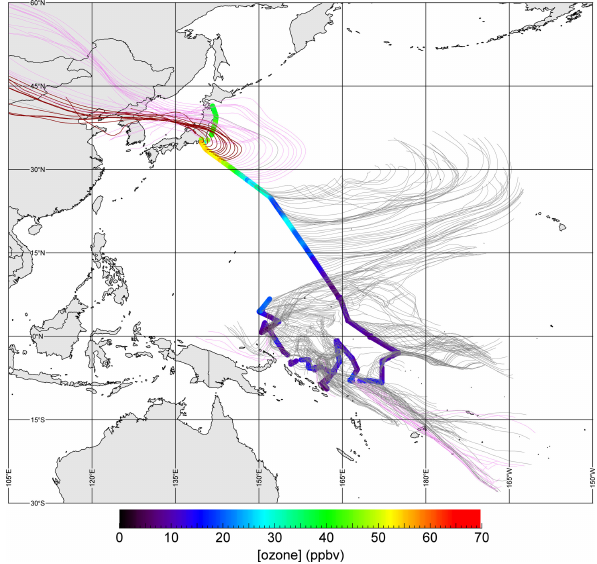
Figure 3. Observed O 3 mixing ratios during MR14-06 Leg 1 and backward trajectories (120h). Magenta lines indicate cases in which trajectory entered regions over land (at altitudes <2500ma.s.l.). Red lines indicate cases in which observed O 3 mixing ratios ex- ceeded